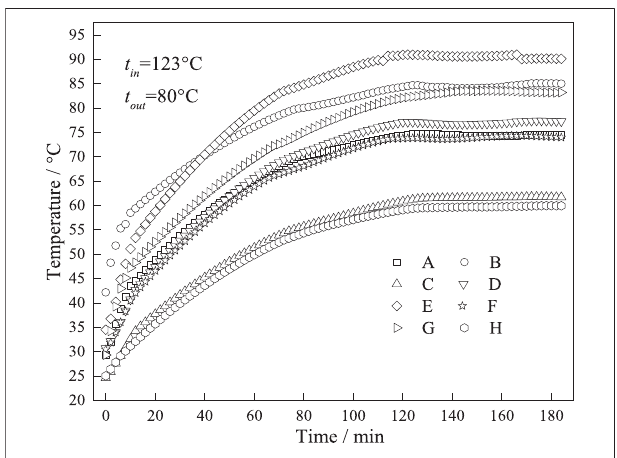
FIGURE4| Thevariationoftemperaturewithtimeatdifferentmeasuring points.